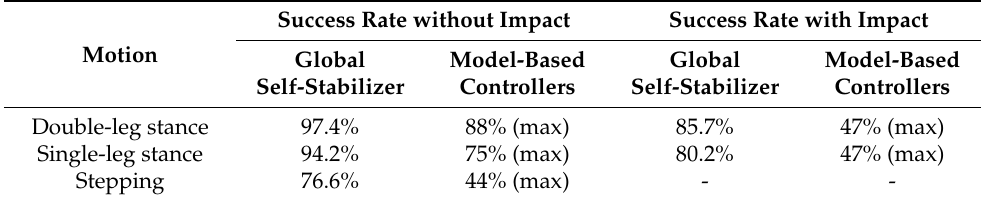
Table 8. Comparison of the simulation success rates of the trained global self-stabilizer and model- based balance